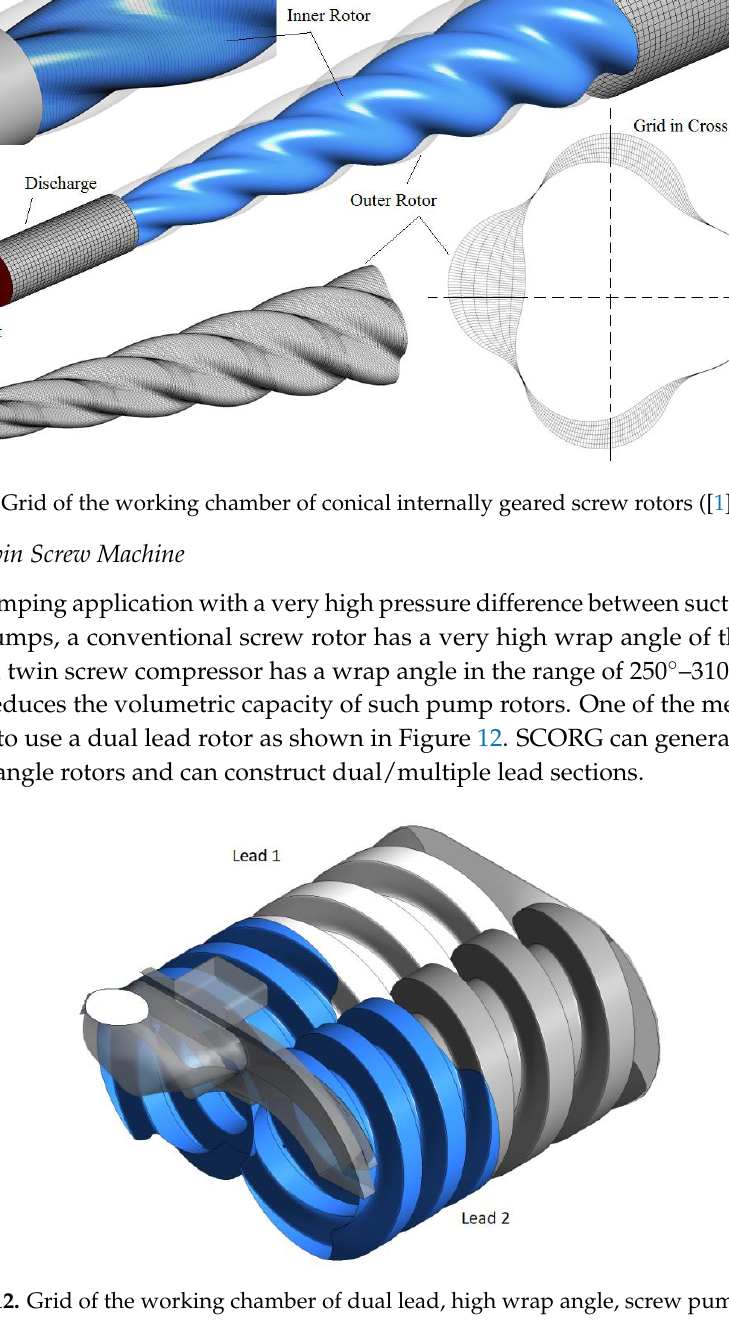
Figure 12. Grid of the working chamber of dual lead, high wrap angle, screw pump rotors.